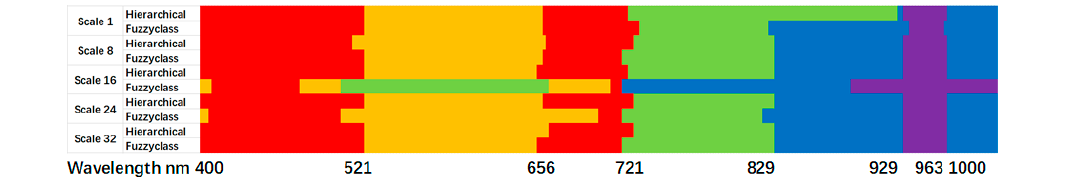
Figure 11. Clustering results of hierarchical clustering method and fuzzy clustering method at five scales. The same color in the figure indicates that the cluster is the same class and there are five categories in total.